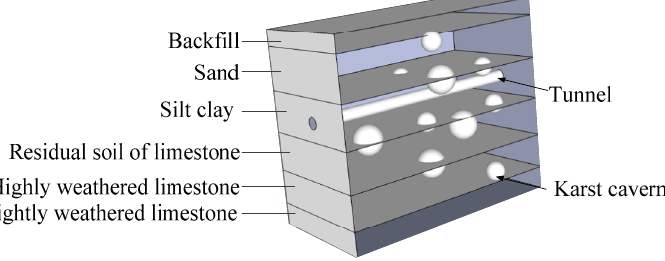
Figure 5. Conceptual representation highlighting the fractal characteristics for the karst caverns discovered in the Ma-Lian